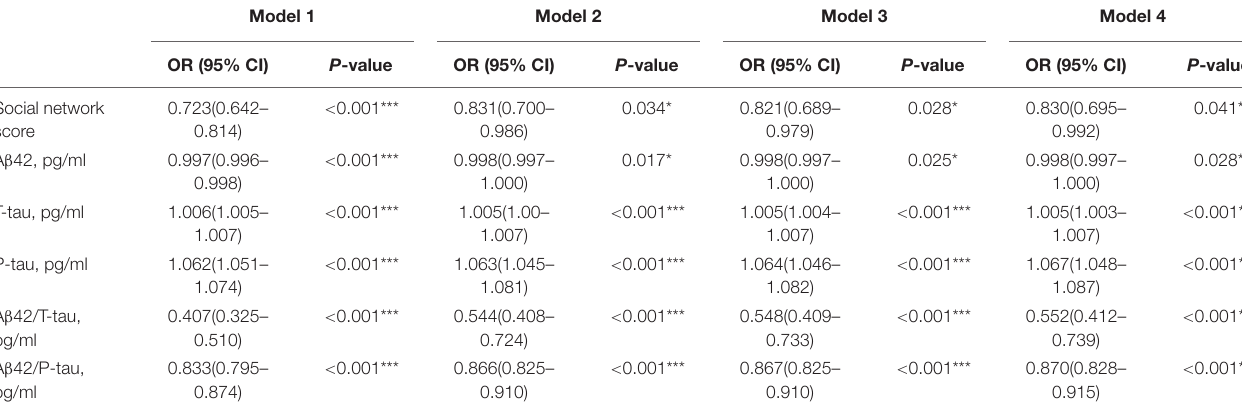
TABLE 2 | Logistic regression analysis and sensitivity analysis in PNDABLE